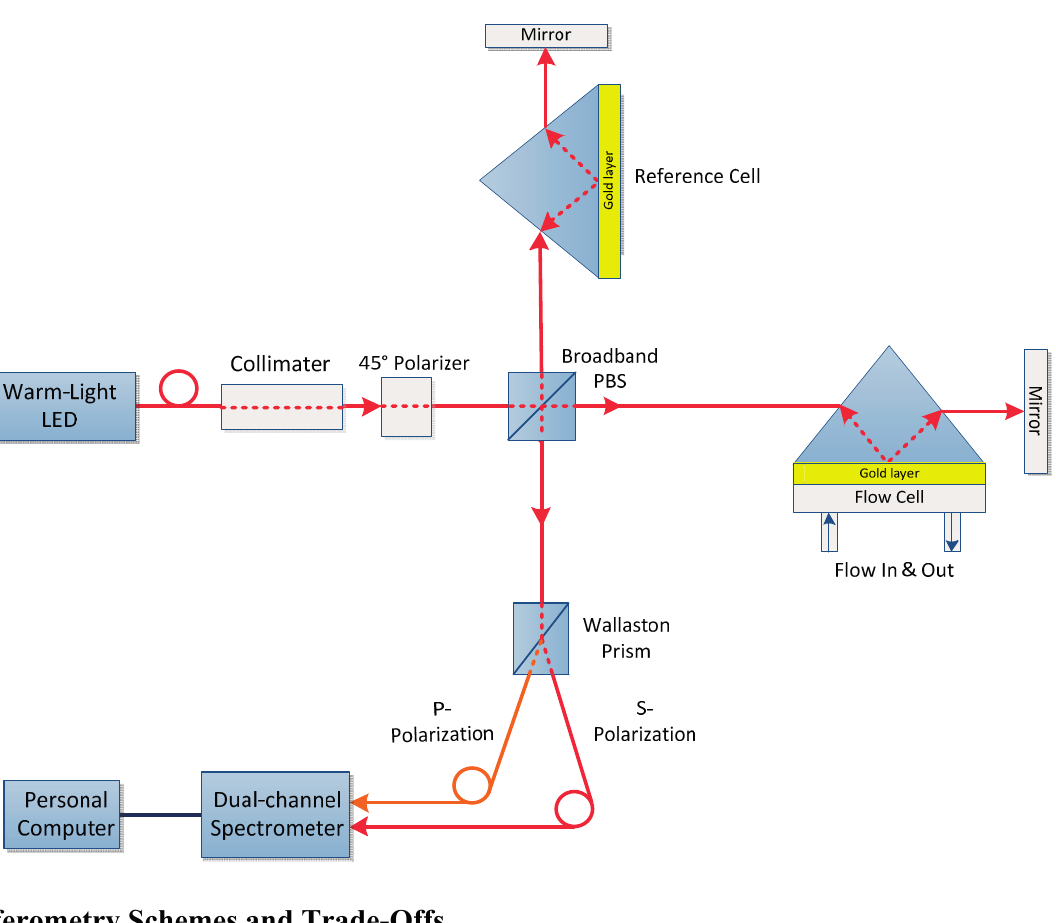
Figure 8. Schematic configuration for a differential spectral Michelson interferometer. NPBS denotes non-polarizing beam splitter